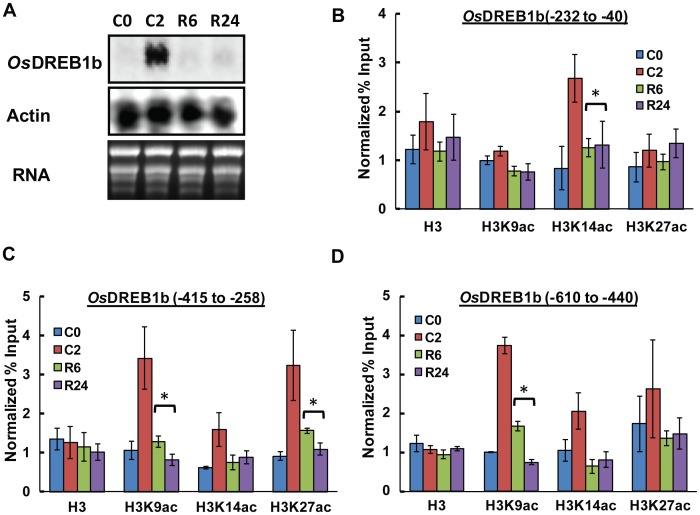
Relative fate of OsDREb1b transcription and histone modifications during cold exposure and subsequent return to normal growth temperature.17 days old rice seedlings were subjected to cold stress and then recovered to normal growth temperature for 6(A) Comparison of OsDREB1b transcript level when plants were returned to normal temperature after cold stress. (B, C and D) Comparison of histone modifications at the OsDREB1b locus during recovery after cold stress. The data represented here is a mean of three independent experiments with standard error bars. Statistically significant values were marked with *.